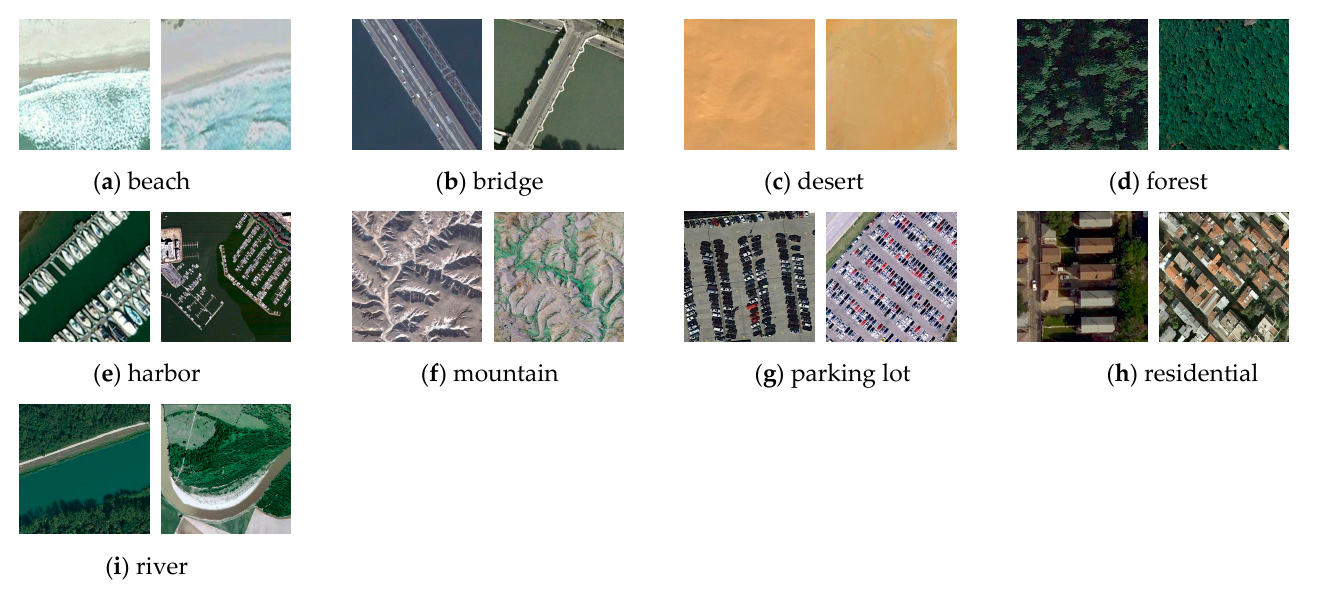
Figure 12. Samples of each common class for NWPU ( left ) and RSI ( right ).